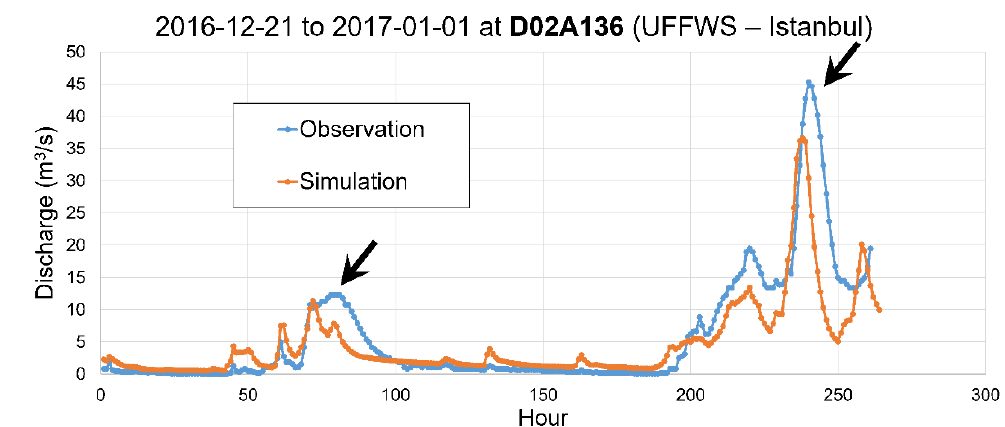
Figure 17. Comparison of observed and simulated flow at a gauging station near the outlet of the Cendere Basin in Istanbul. The two arrows point to the two precipitation events during this period.